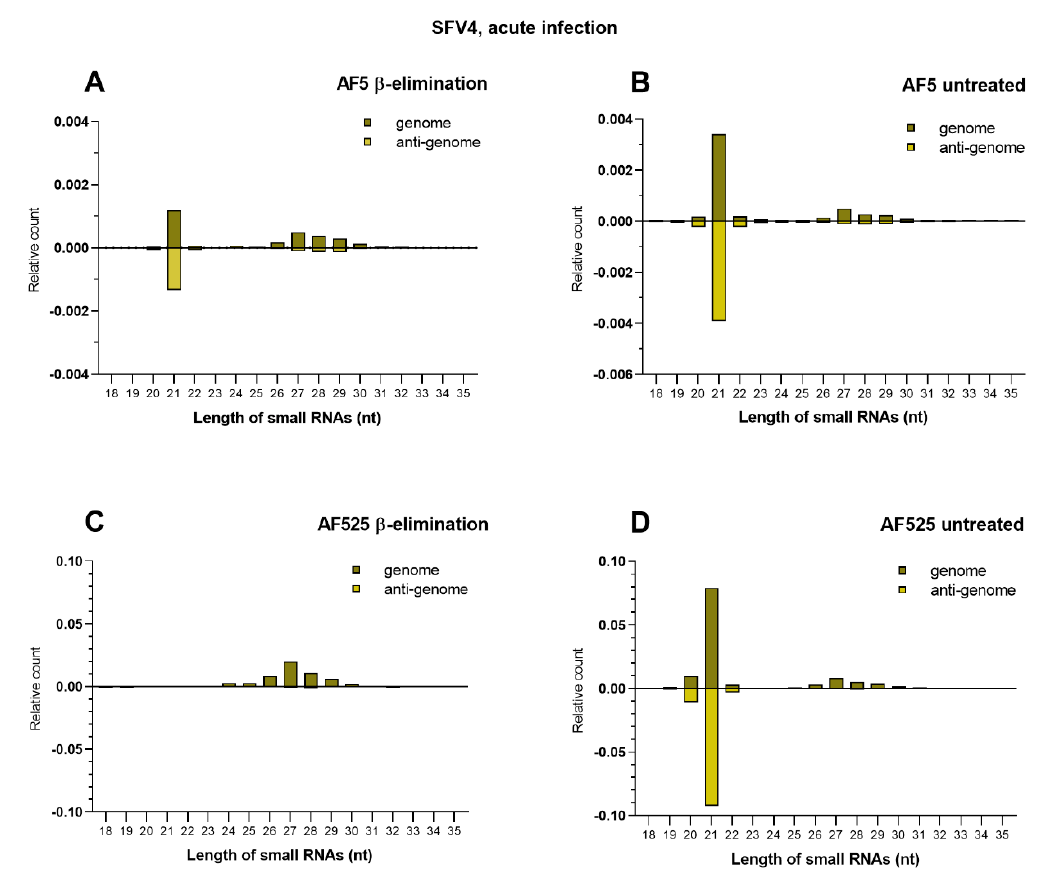
Figure 2. Length distribution of small RNAs in AF525 and AF5 cells treated with β -elimination reagents . NGS data of AF525 and AF5 cells was mapped to the SFV4 genome and anti-genome. Positive numbers are RNAs mapping to the sense strand of SFV4 (dark green), while negative numbers indicate RNAs mapping to the anti-sense strand of SFV4 (light green). Y -axis: relative count of small RNAs normalized to clean reads. ( A ) AF5 cells treated with complete β -elimination reagents. ( B ) AF5 β -elimination control. ( C ) AF525 cells treated with complete β -elimination protocol. ( D ) AF525 control. Two independent experiments were carried out and the results of one representative experiment is shown here (sequencing I).